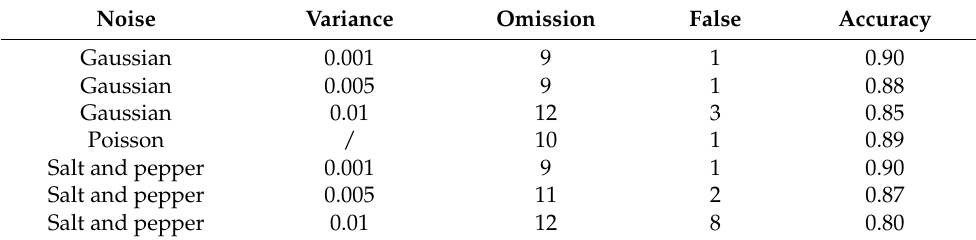
Figure 13. Missing insulator cap detection . ( a ) Glass insulator with 1 * 16 installation, ( b ) glass insu- lator with 2 * 16 installation, ( c ) glass insulator with 1 * 8 installation, ( d ) porcelain insulator with 2 Table 4. The influence of noise on the detection effect. * 30 installation.